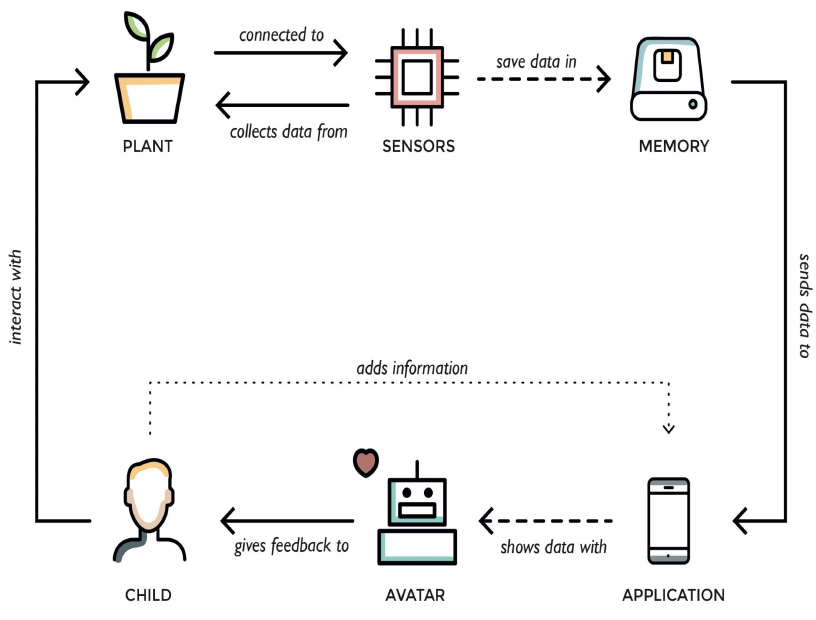
Figure 1. Technical